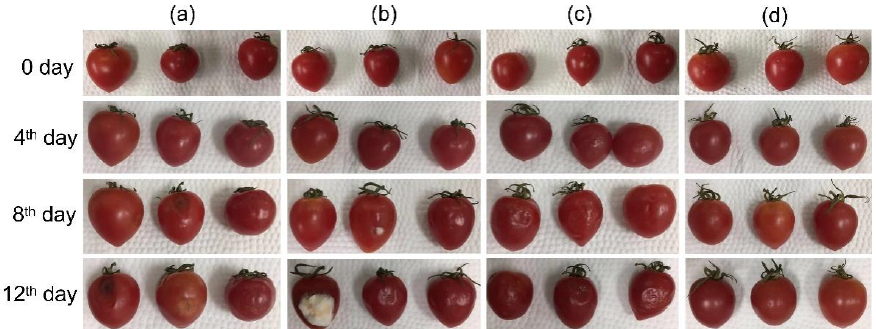
Figure 10. Package application of cherry tomatoes: ( a ) controlled group without packaging; ( b ) F4- packaged group; ( c ) F5-packaged group; ( d ) F6-packaged group.